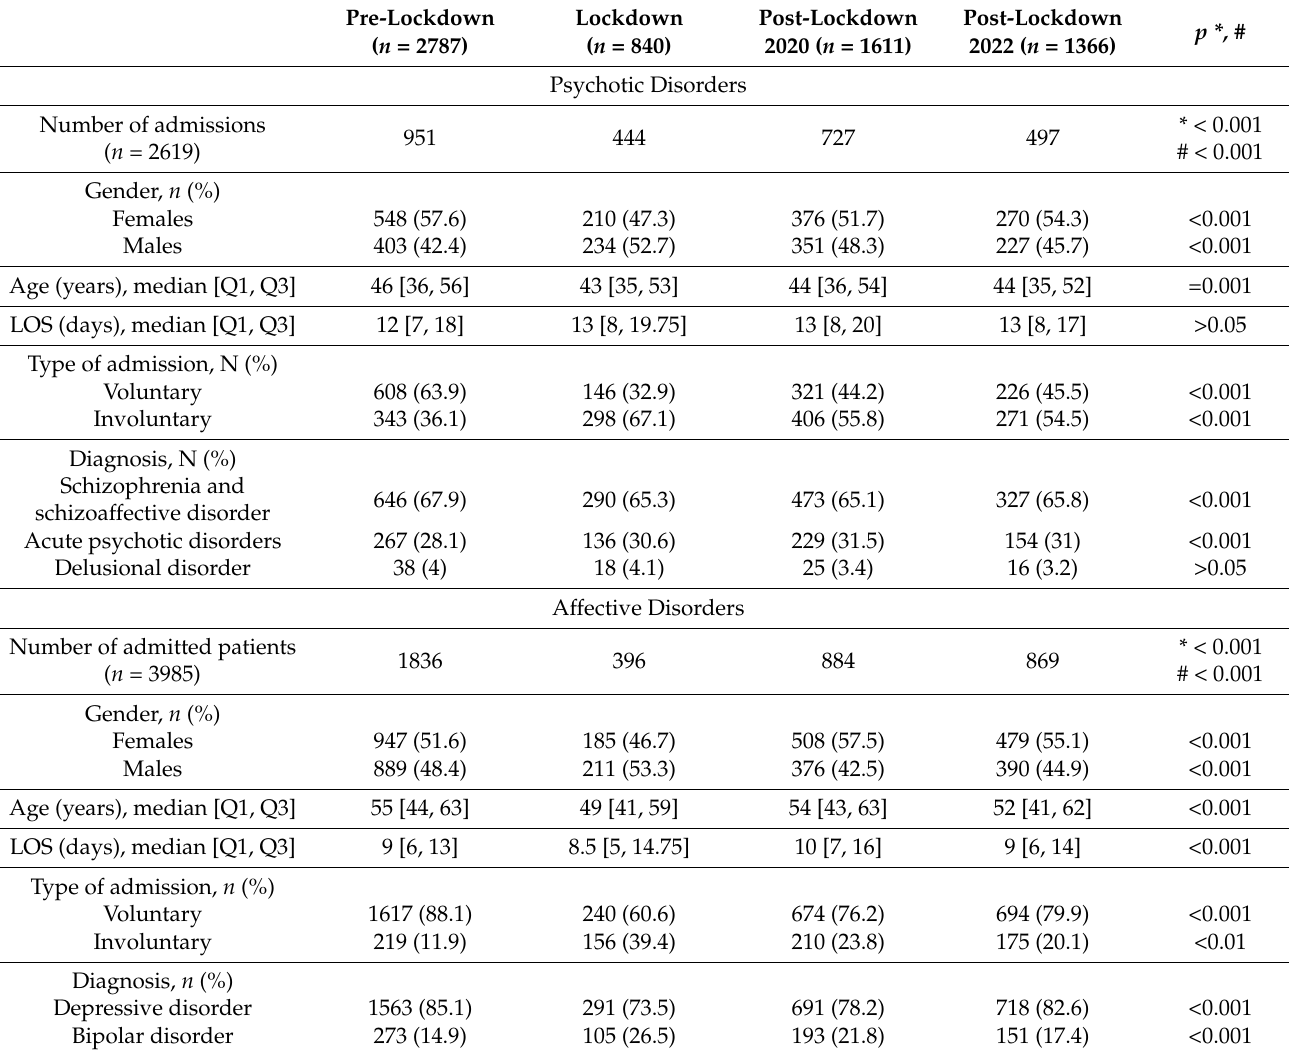
Table 1. Socio-demographic, clinical, and administrative characteristics of psychiatric admissions during the COVID-19 lockdown period in comparison with the pre-lockdown period, post-lockdown period, and the lockdown corresponding period in